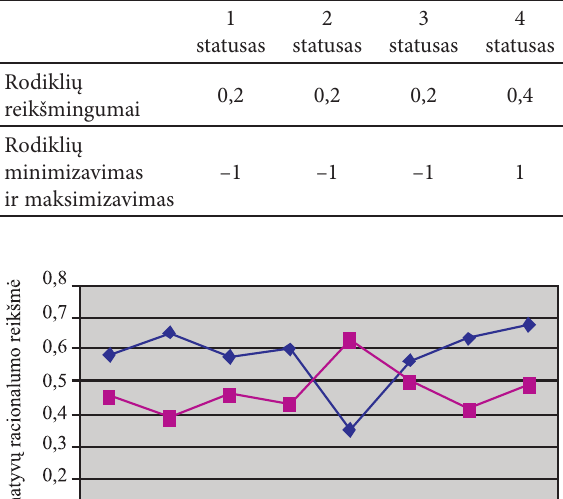
Table 3. The results of the alternatives evaluation